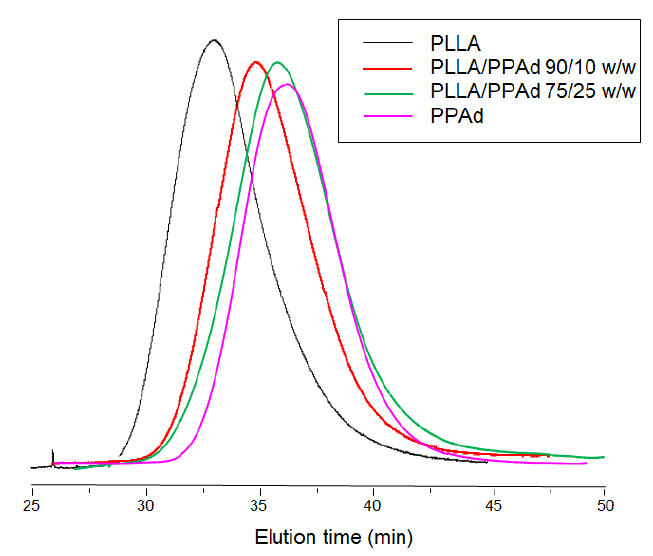
Figure 2. Gel permeation chromatography of poly( L -lactide) (PLLA), poly(propylene adipate) (PPAd) and PLLA- b -PPAd copolymers.